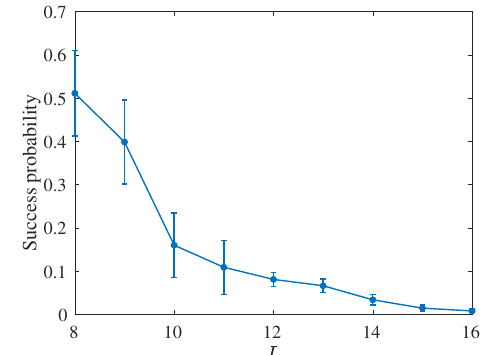
FIG. 21. Success probability for MWPM on the logical-planted instances. The data symbols correspond to the average success probability calculated using 1000 bootstraps of 100 instances for L < 12 and of 1000 instances for L ≥ 12 , and the error bars represent the 95% confidence intervals ( 2 σ ) calculated from the same bootstrap.